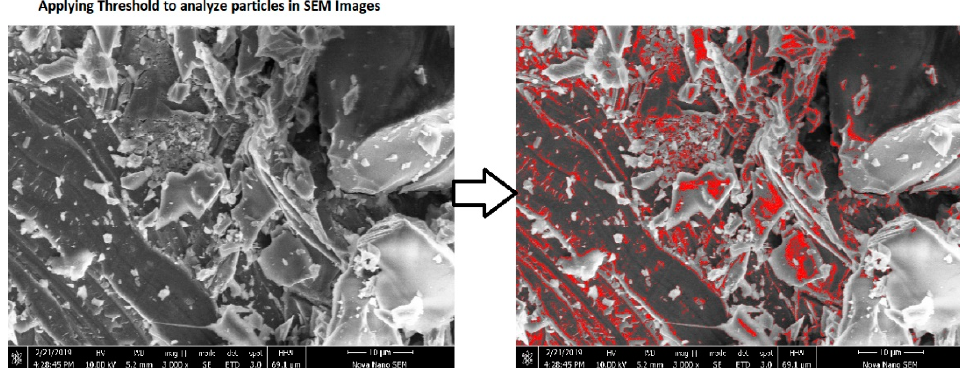
Figure 7. Threshold level applied to visualize the particles. Table 8. Analysis of pores by Image J.